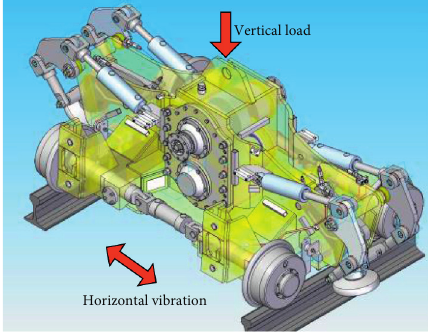
Figure 2: The principle of stabilizing